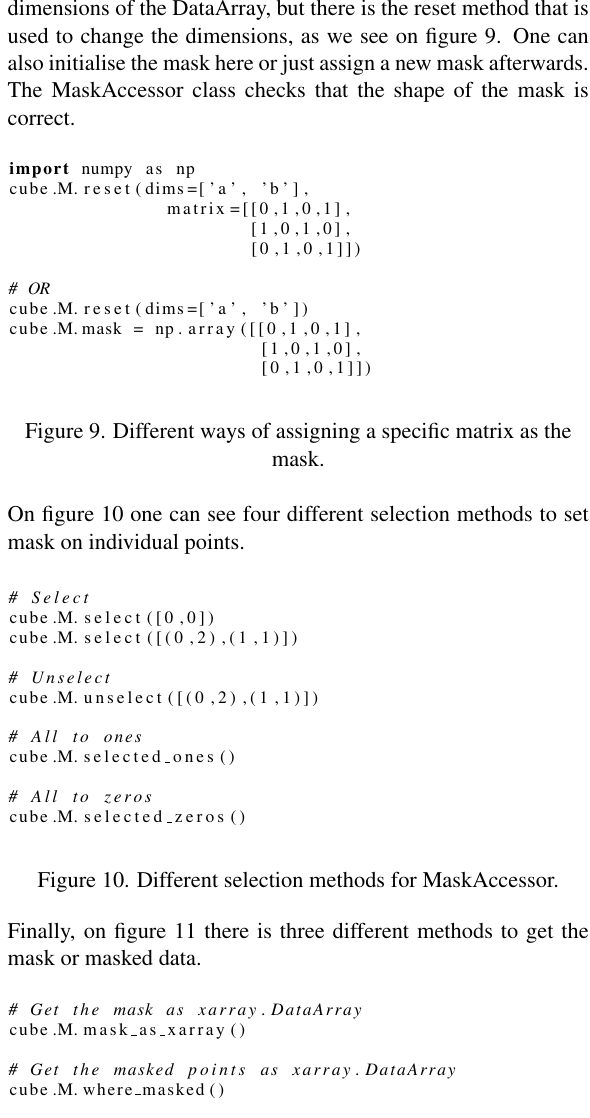
Figure 11. Methods for getting data out of MaskAccessor and underlyind DataArray.